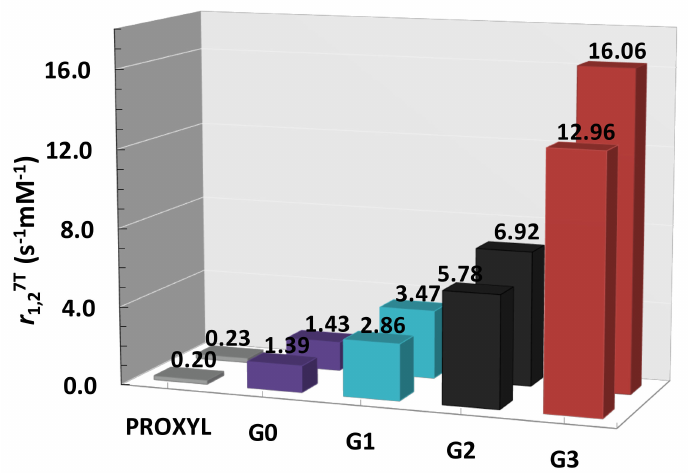
Figure 3. Longitudinal (r 1 ) and transverse (r 2 ) relaxivity per molecule of PPH Gn-Tyr-PROXYL (n = 0,3) radical dendrimers determined at 7T in 100 mM phosphate buffer pH 7.4, 300 K. Published by ACS Appl. Bio Mater . in 2020